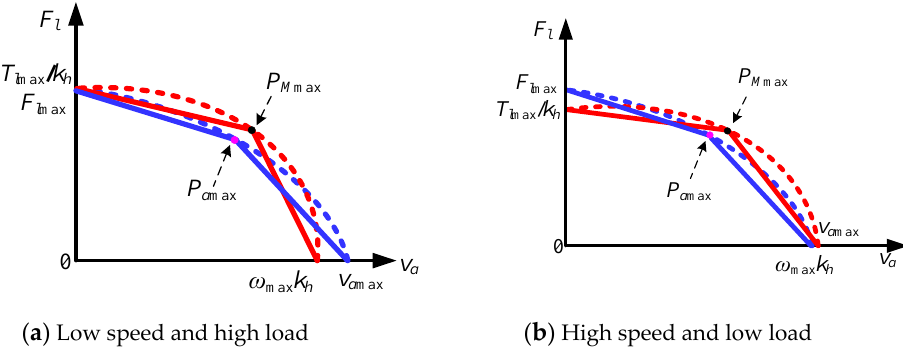
k . h k is a fixed h